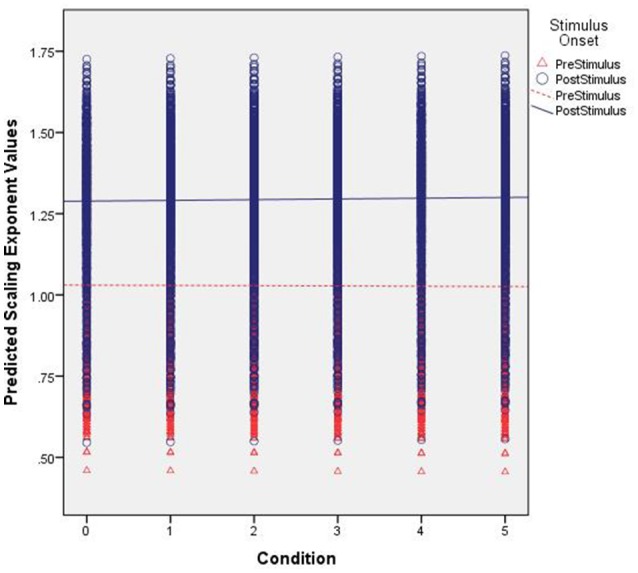
Predicted scaling exponent values. The figure shows the predicted scaling exponents (α) across increasing levels of familiarity (left to right along the x axis) and segmented by pre- (red triangles) and post-stimulus (blue circles).